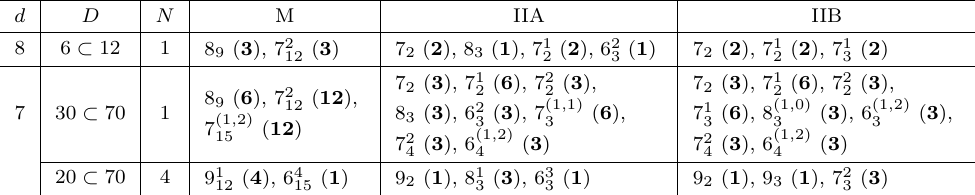
Table 21 . Missing states in the 6-brane multiplet.